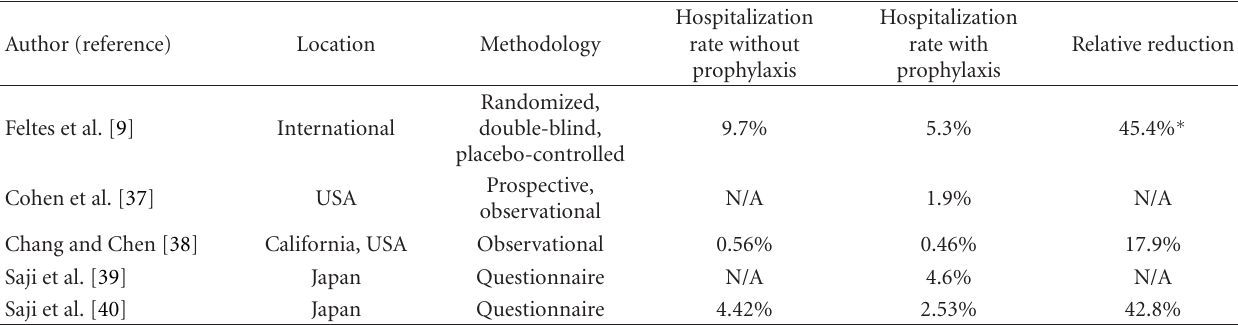
Table 3: Palivizumab prophylaxis in children with CHD and its impact on RSV hospitalization